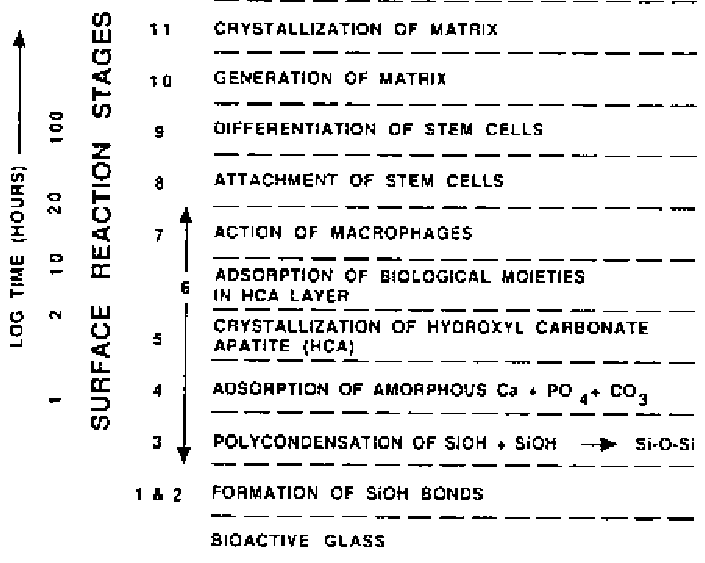
Figure 4. The sequence of interfacial reactions involved in forming a bond between tissue and bioactive glasses. The border between “dead” and “alive” occurs approximately at stage 6. For want of anything better, the bioactivity mechanism of calcium orthophosphate cements should also be described by this scheme with omitting of several initial stages, as it was made for HA in Ref. [315], where 3 initial chemical stages of the Hench’s mechanism were replaced by partial dissolution of HA. Reprinted from Ref. [314] with